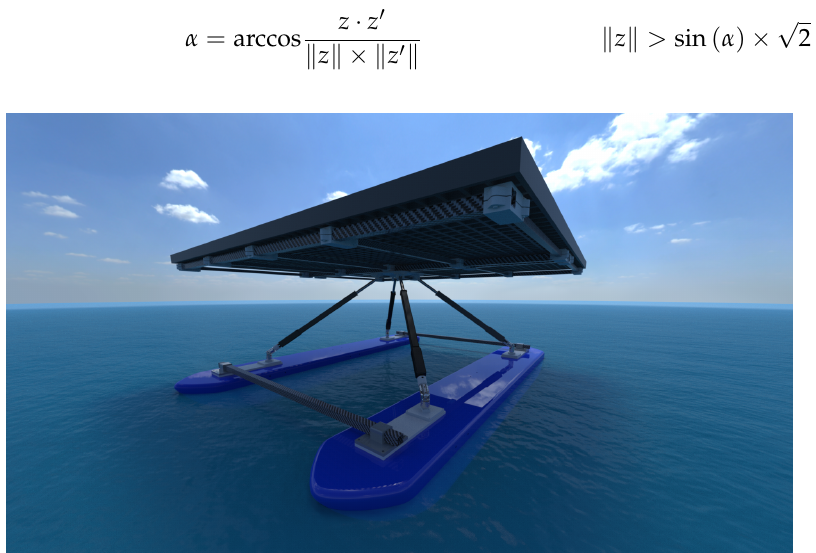
Figure 4. 3D model of the 4-UPR platform mechanism.